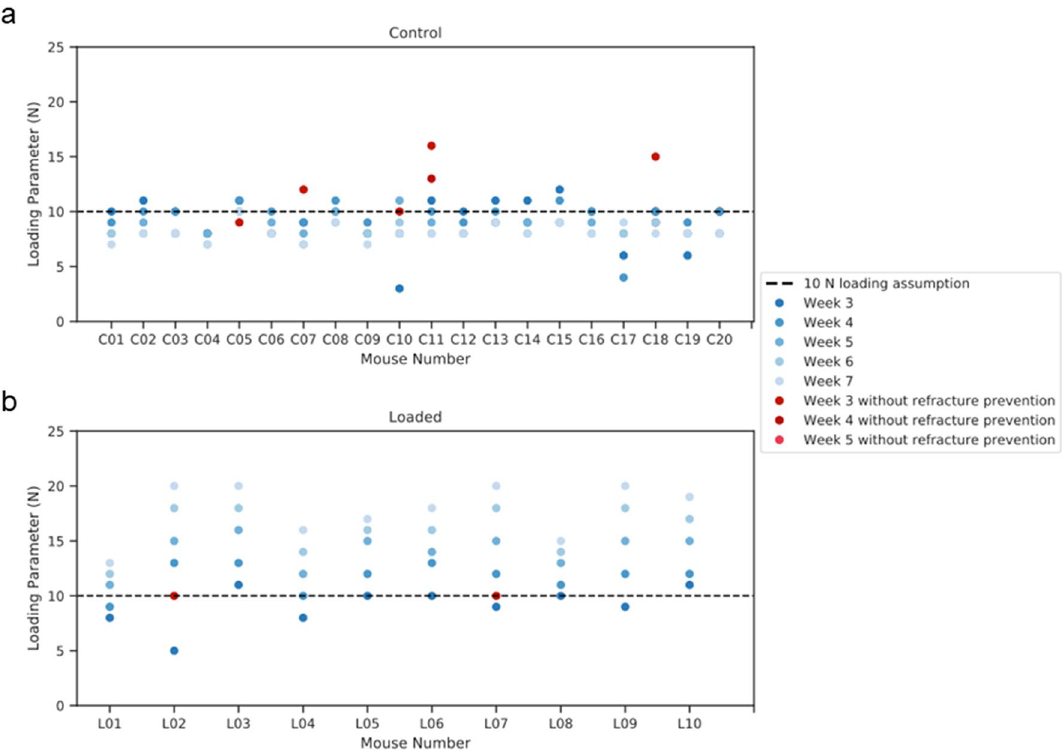
Figure 4. Loading parameters relative to the 10 N assumption, determined by rtFE. ( a ) A decreasing load is needed to maintain a consistent mechanical environment in a control group. ( b ) An increasing load is needed to maintain a consistent mechanical environment in a loaded